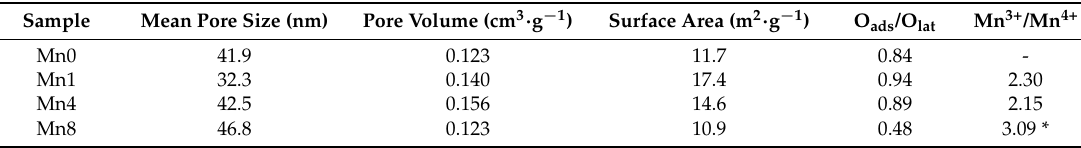
Figure 3. XPS spectra of catalysts with different contents of Mn synthesized in this work by hydrothermal method and calcined at 600 °C for 5 h ( a ) Mn 2p 3/2 ( b ) O 1s . Table 2. Textural and superficial properties of catalysts synthesized in this work.